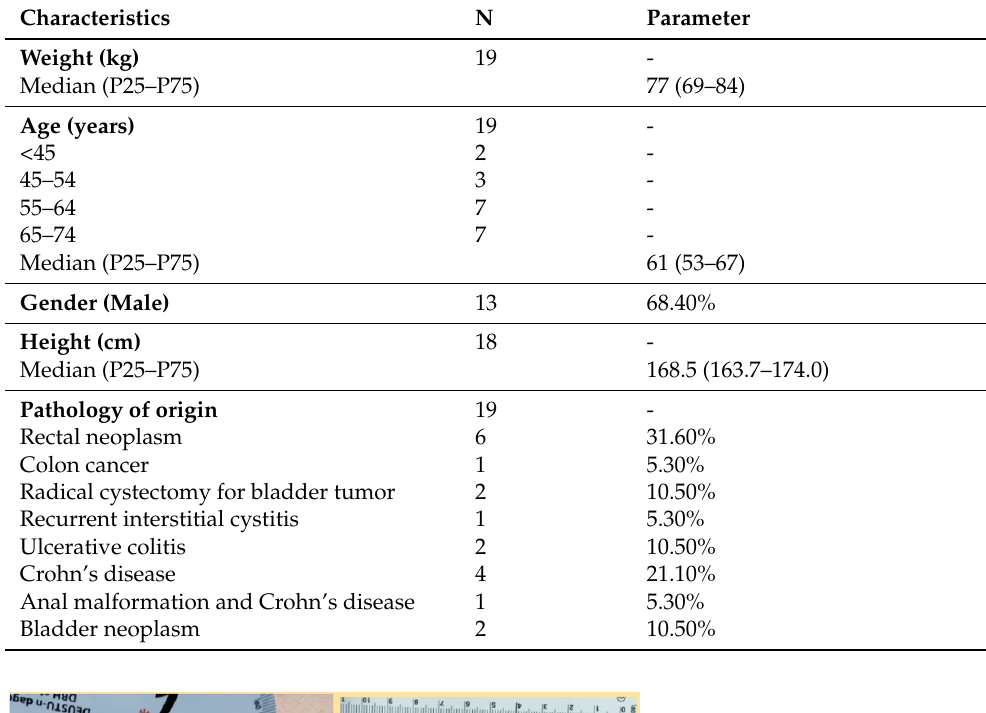
Table 1. Characteristics of the population.